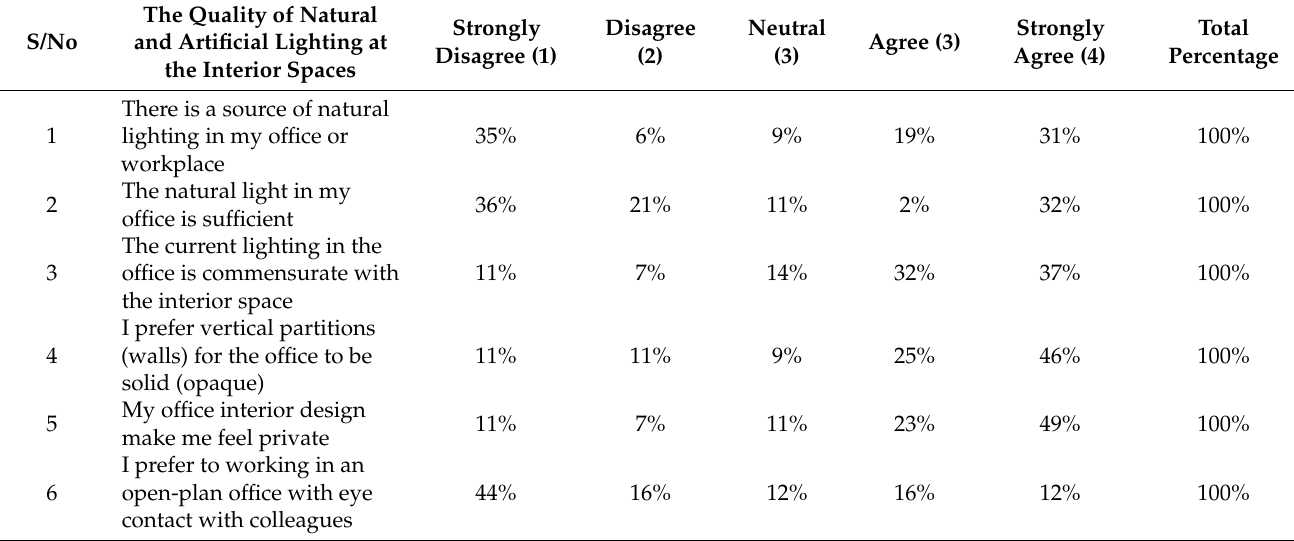
Table 3. Assessment of the quality of natural and artificial lighting at the interior